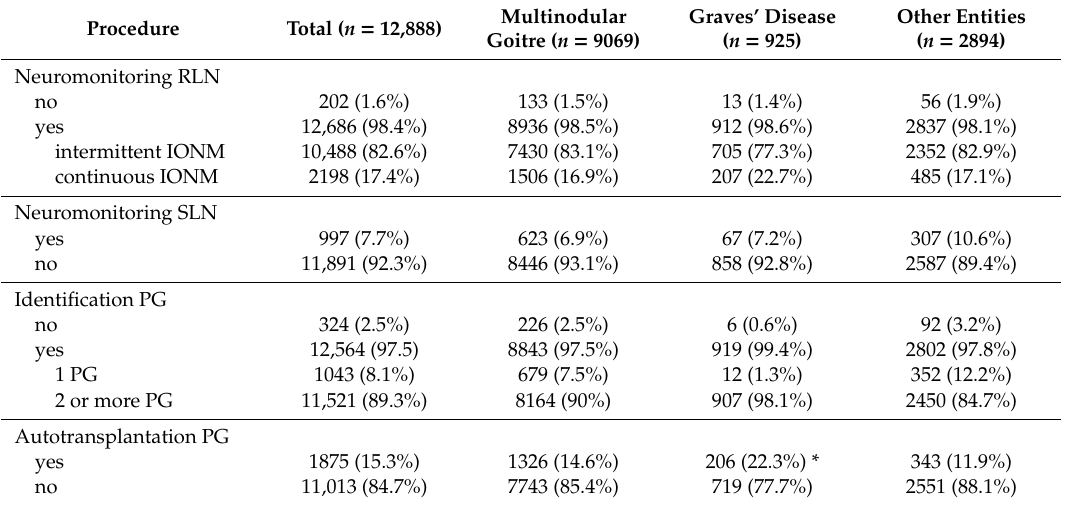
Table 4. Intraoperative neuromonitoring, visualisation and autotransplantation of parathyroids.